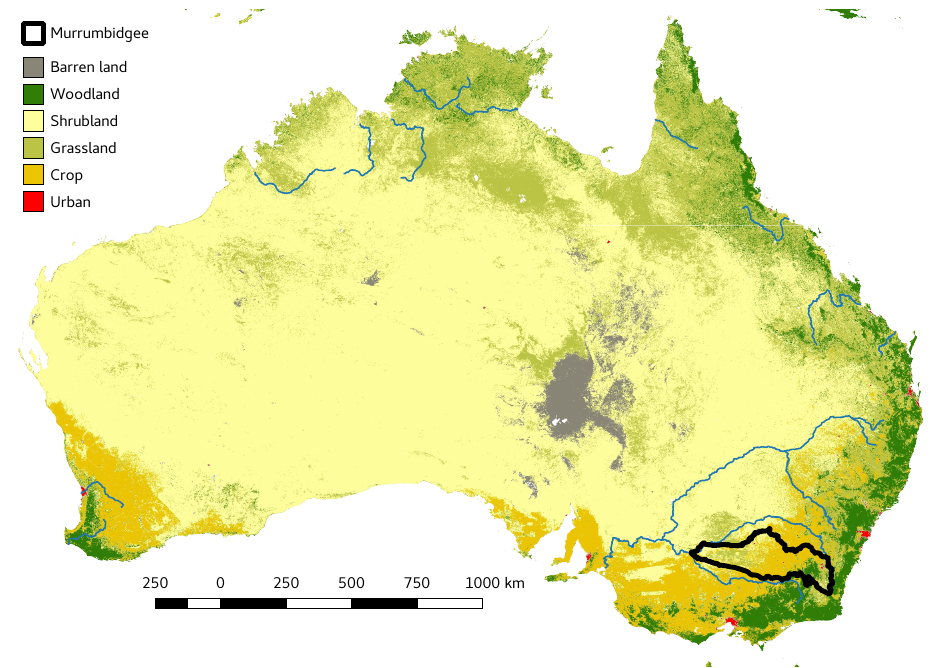
Figure 1. CLM plant functional types based on MODIS MCDQ12 land cover classification and ECOCLIMAP climate zones at 500m resolution prior to the aggregation to 0.25 ◦ . Some classes are here aggregated for visualisation purposes, e.g. evergreen temperate and evergreen tropical forests are both shown as woodland. The boundary of the Murrumbidgee catchment, which is the site of the OzNet in situ measurements, is